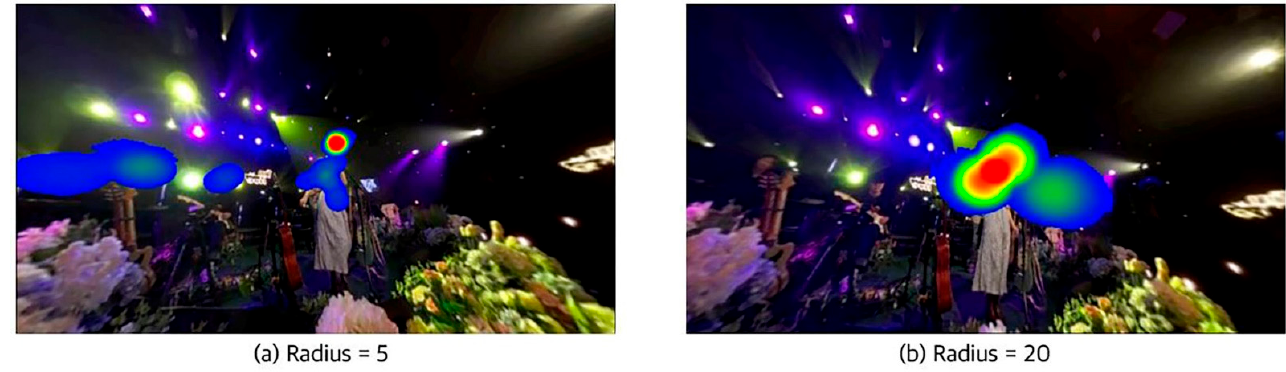
Figure 11. Heatmap comparison based on radius value.